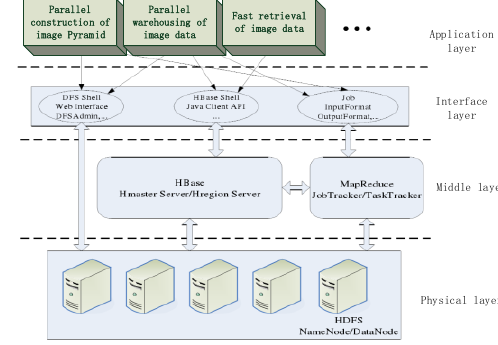
Figure 1 Hadoop technical architecture diagram